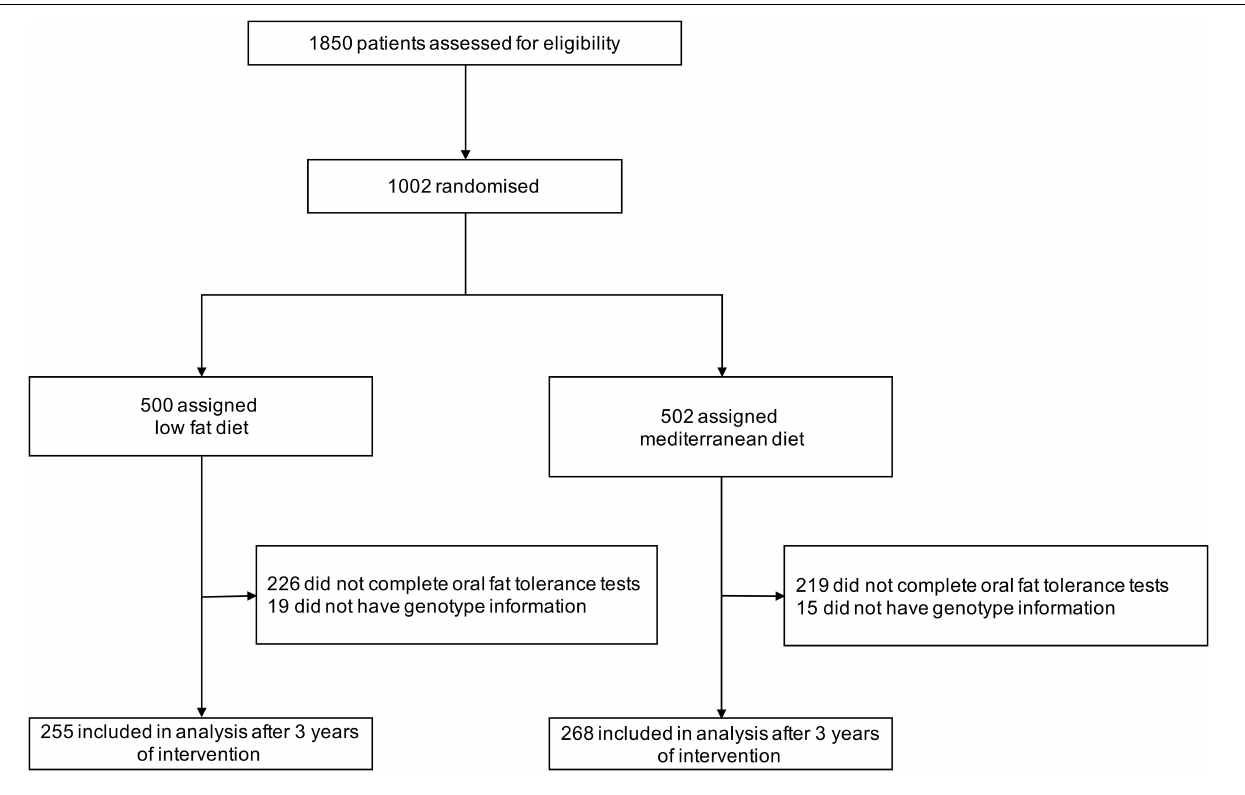
FIGURE 1 | Flow-chart of the